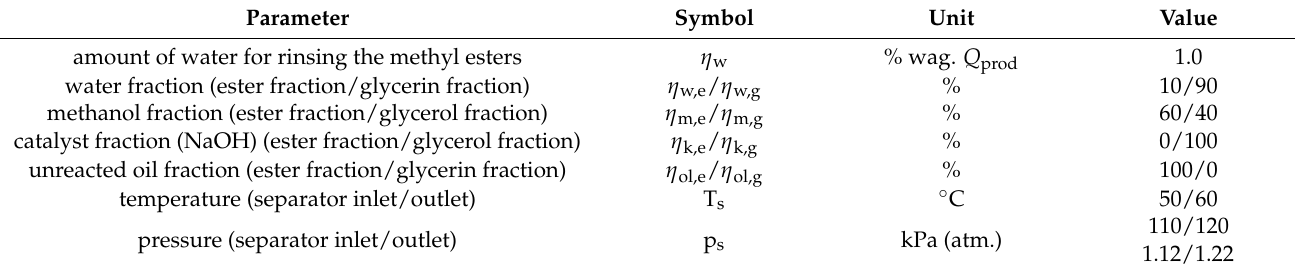
Table 3. Technological assumptions for the separation of methyl esters and glycerin fraction. Parameter